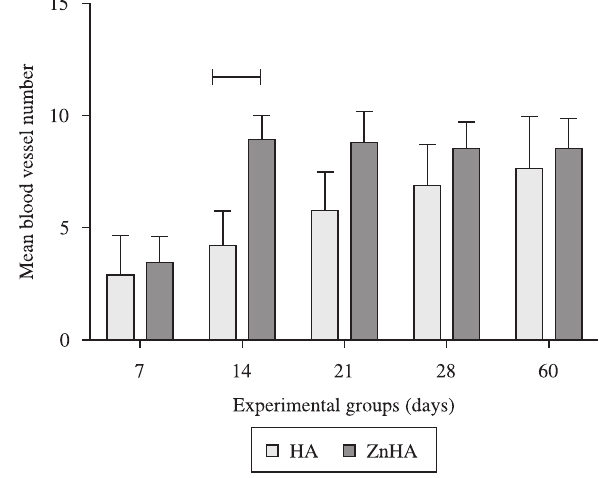
Figure 6. Histomorphometrical analysis of angiogenesis on the grafted areas. Results represented as mean counts of blood vessels. Bars represent significant differences between groups (p <